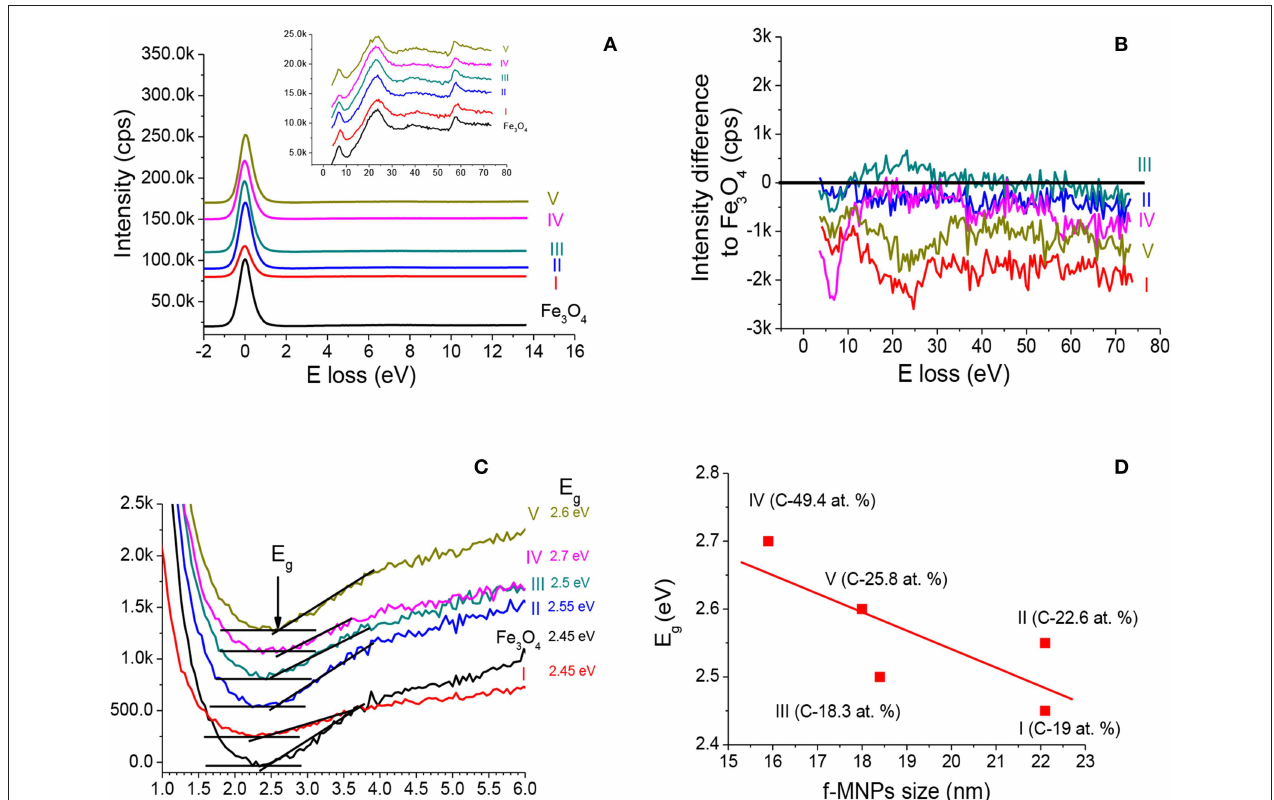
FIGURE 10 | (A) Comparison of elastic peak and spectrum of inelastic losses of electrons on valence band electrons recorded from Fe 3 O 4 MNPs and f-MNPs. (B) Differences between the spectrum of inelastic losses of electrons on valence band electrons recorded from Fe 3 O 4 f-MNPs and the respective spectrum recorded from Fe 3 O 4 MNPs. (C) Evaluation of band gap energy values from REELS spectra recorded from Fe 3 O 4 MNPs and f-MNPs. (D) Dependence of band gap energy values on Fe 3 O 4 f-MNPs nanoparticle size (Rangam et al., 2017) and surface carbon content ( Supplementary Table S1 ).